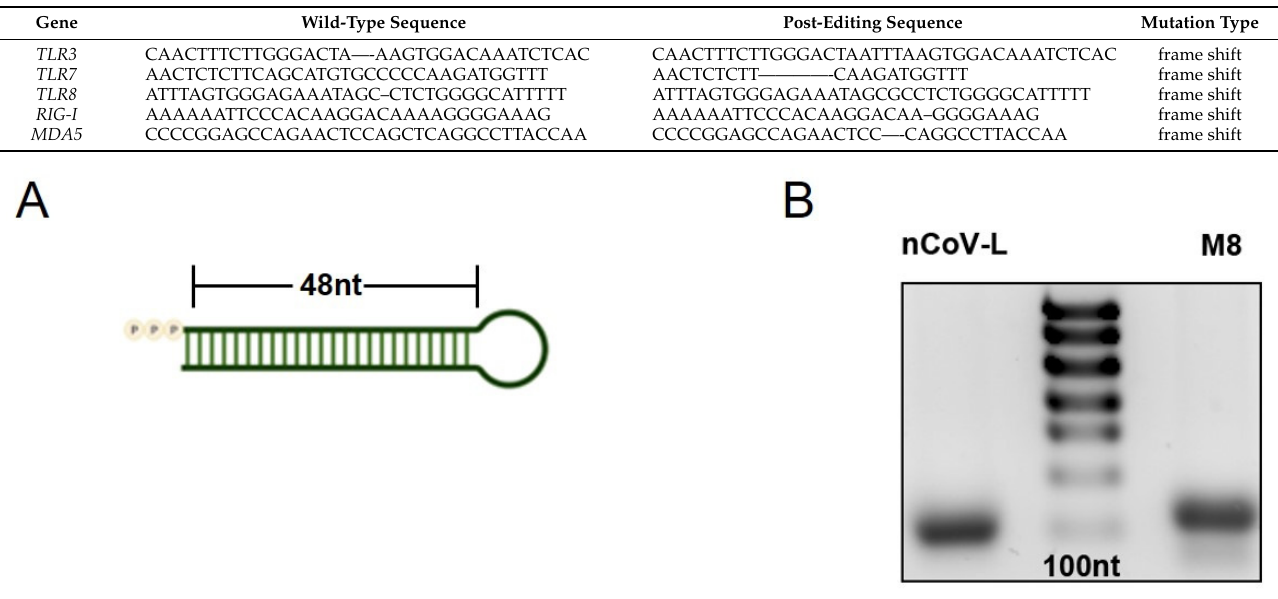
Table A1. Sequences of knockout cell lines.